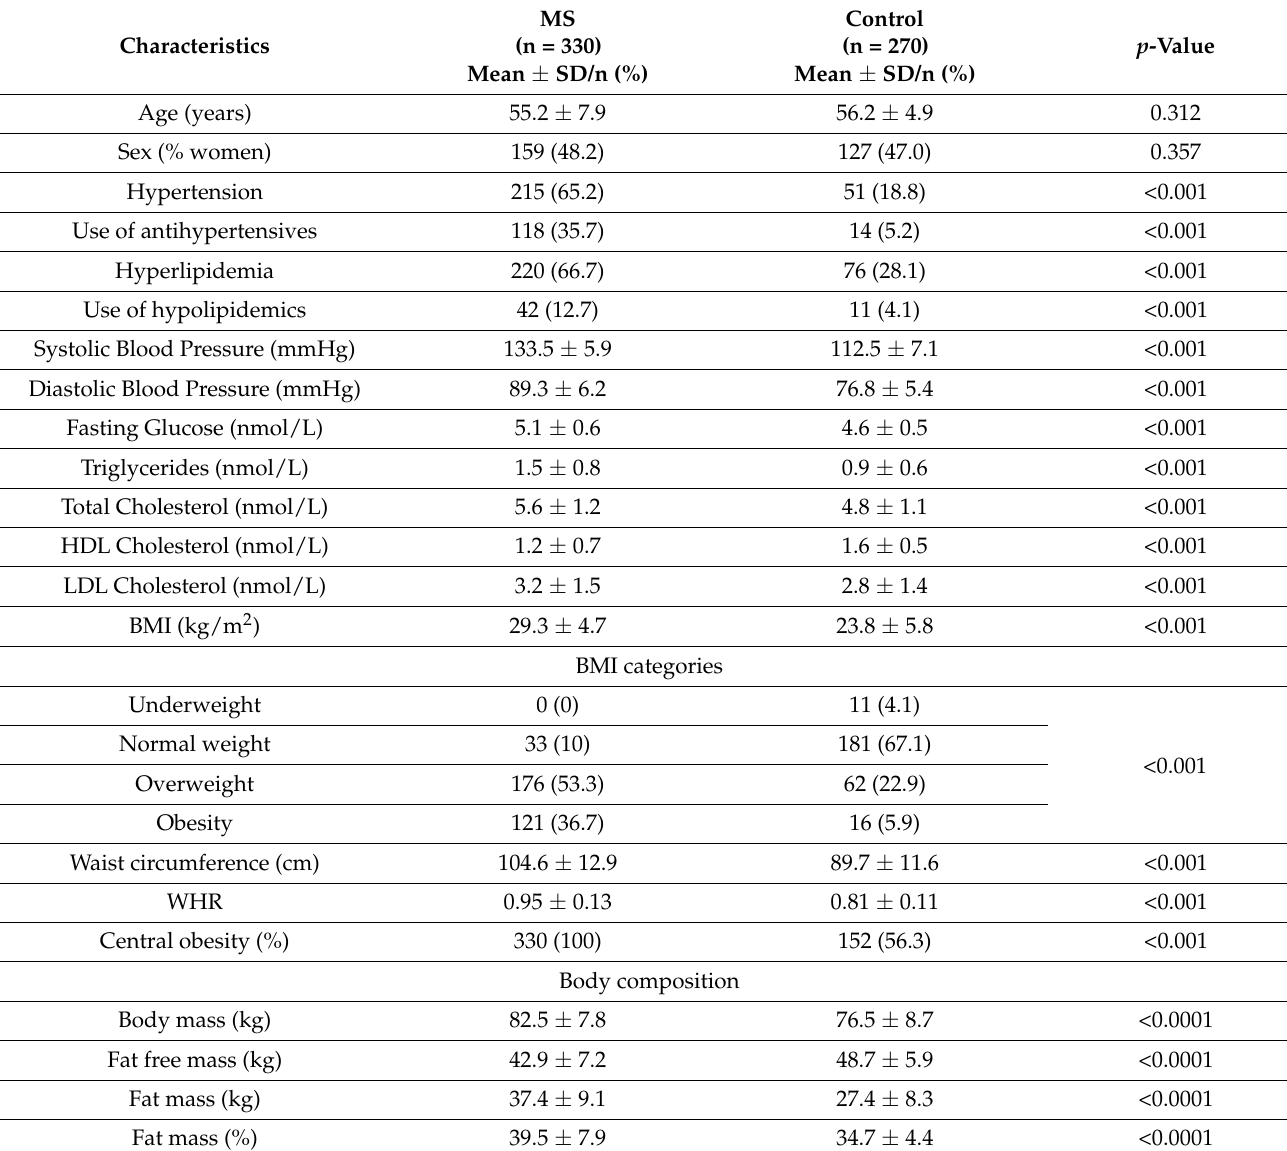
Table 1. General characteristics of study